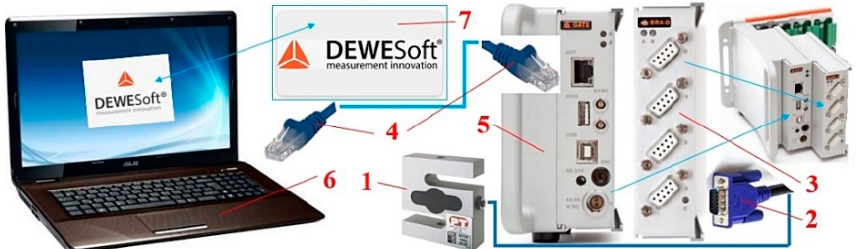
Figure 4. Measuring chain for the experimental measurement of conveyor belt tensile force: 1—load sensor; 2—D-sub plug; 3—measuring module BR4D of the strain gauge apparatus DS NET; 4—network cable; 5—gateway module DS GATE; 6—laptop; 7—software DEWESoft X2 SP5.